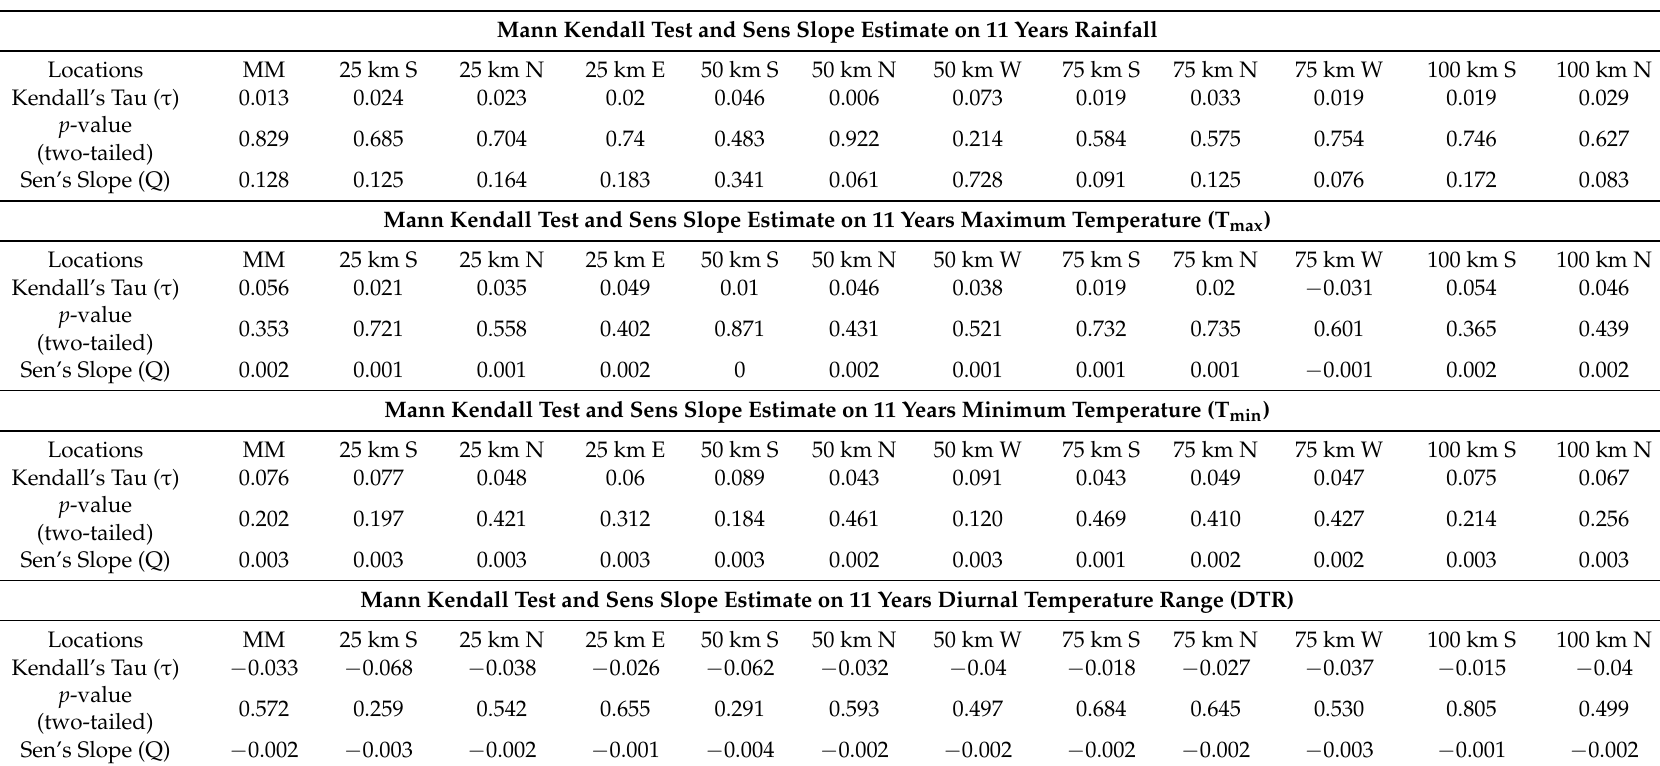
Table 3. Mann–Kendall results for the period 2000–2010. Mann Kendall Test and Sens Slope Estimate on 11 Years